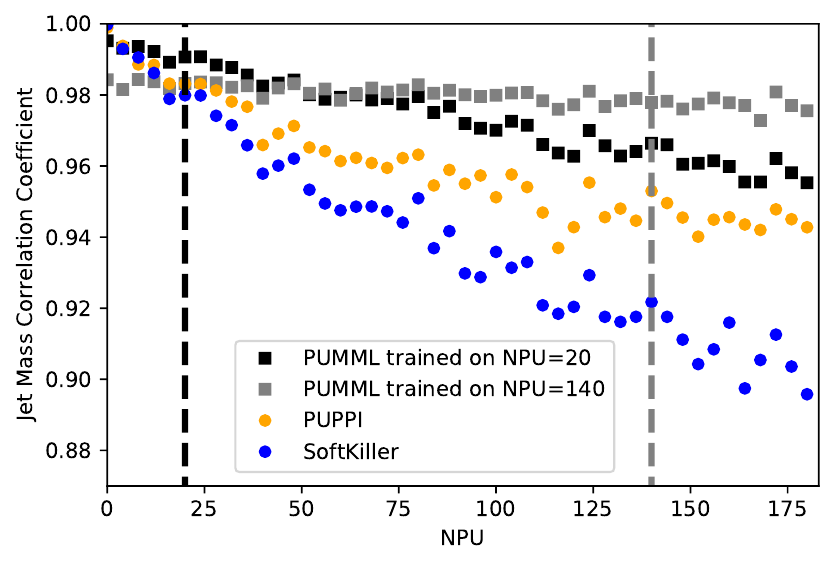
Figure 6 . Correlation coe(cid:14)cients between reconstructed and true jet masses plotted as a function of NPU for the di(cid:11)erent pileup mitigation schemes. PUMML was trained on 50 k events with either NPU= 20 or NPU= 140 indicated by dashed vertical lines. The performance of PUMML with Poissonian h NPU i = 140 is similar to the NPU= 140 curve. PUMML is surprisingly performant well outside the NPU range on which it was trained and consistently outperforms PUPPI and SoftKiller. Note that PUMML trained on the lower NPU sample better reconstructs the jet mass in the low pileup